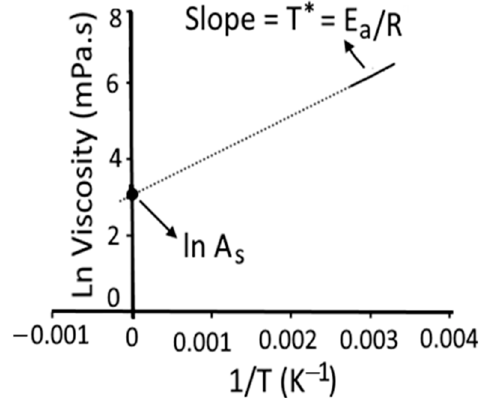
Figure 2. Graphical representation for determination of the Arrhenius parameters: activation energy (E a /R), the logarithm of pre-exponential factor (ln A s ), and Arrhenius activation temperature (T*, K). R = universal gas constant [20]. Figure 2 was reconstructed using experimental data of the present study, which was based on Messaâdi et al. [20] and is available under the Creative Commons At- tribution License.